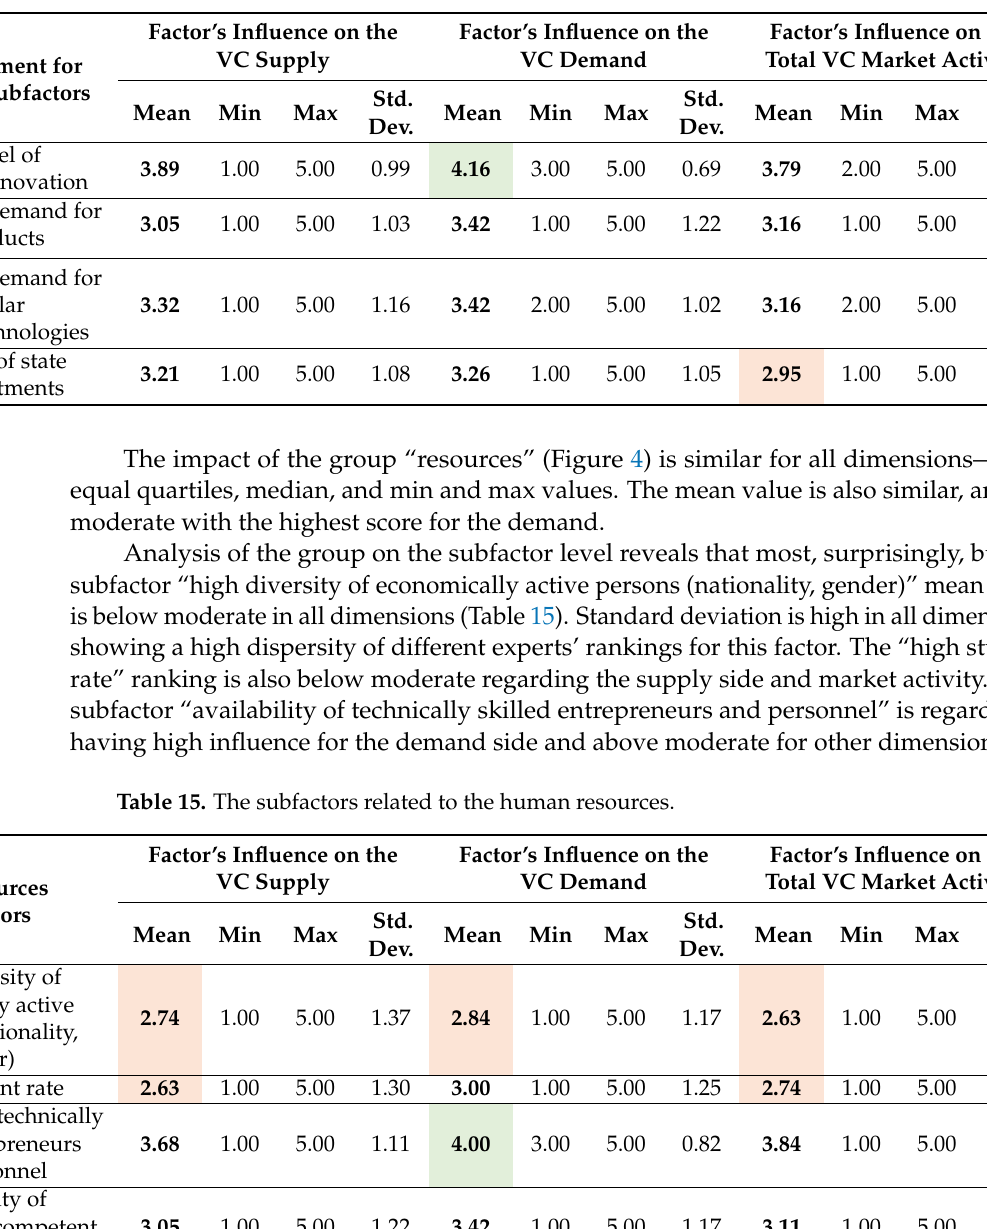
Table 14. The subfactors related to the environment for innovation.